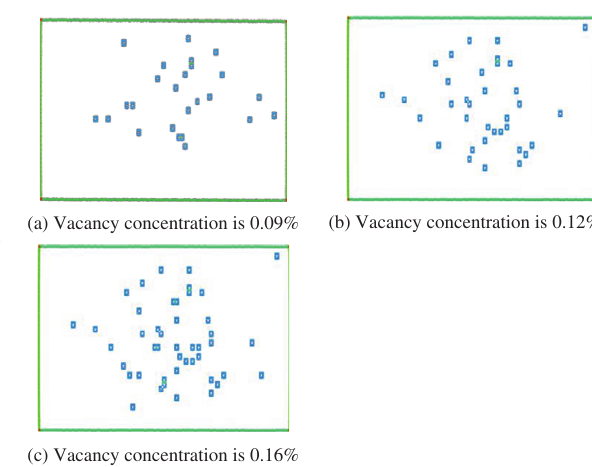
Figure 2: Atom model of γ -TiAl alloy at three vacancy